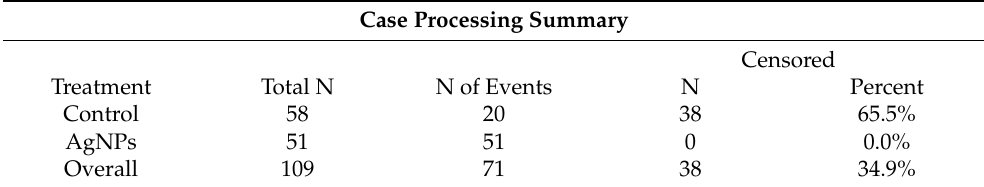
Table 8. Kaplan–Meier Method (Groups 2a and 2b).